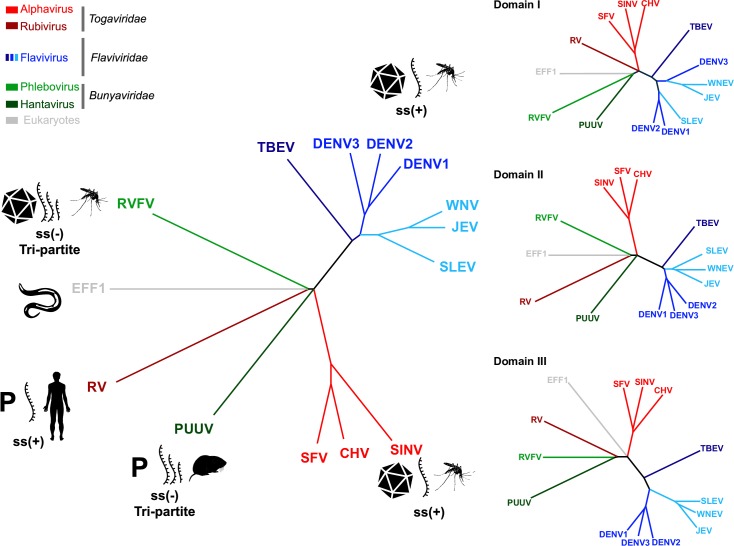
Structural and evolutionary relationships in class II fusion proteins.Cladograms representing the structural relationships between different class II fusion proteins. The coordinates of PUUV GC were submitted to the DALI server. Atomic coordinates were obtained from the Protein Data Bank (PDB). Structure based alignment of the collected coordinates was performed with MUSTANG. A dendrogram was estimated based on a neighbor-joining analysis of the aligned sequences and guided by the BLOSUM62 substitution matrix. Abbreviations and their respective PDBs are as follows: dengue virus 2 (DENV-2, 1OK8-A), tick-borne encephalitis virus (TBEV, 1SVB-A), dengue virus 3 (DENV-3, 1UZG-A), Semliki forest virus (SFV, 1RER-A), West Nile virus (WNV, 2I69-A), Dengue virus 1 (DENV-1, 3G7T-A), Sindbis virus (SINV, 3MUU-A), Chikugunya virus (CHV, 3N41-F), Japanese encephalitis virus (JEV, 3P54-A), rubella virus (RV, 4ADG-A), St. Louis encephalitis virus (SLEV, 4FG0-A), Rift valley fever virus (RVFV, 4HJ1). C.elegans EFF1 (4OJC-A) was added as an out-group. Color scheme is per legend. Icosahedron icon represents icosahedral envelope, P- pleomorphic envelope. Genome type and transmission vectors are indicated by representative symbols.